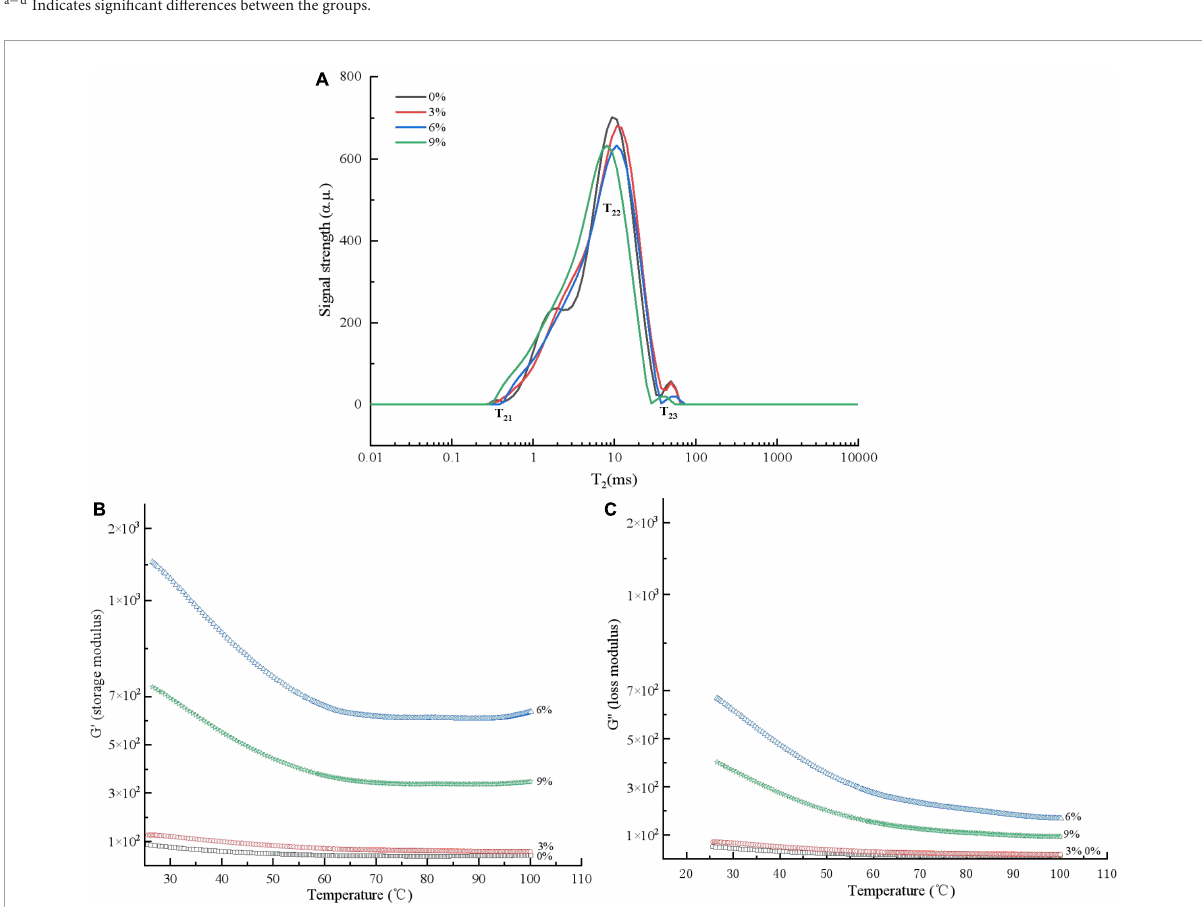
FIGURE4 Water distribution and rheological properties of the dough treated with different MMBP amounts (0, 3, 6, and 9%). (A) Water distribution, (B) storage modulus, and (C) loss modulus.